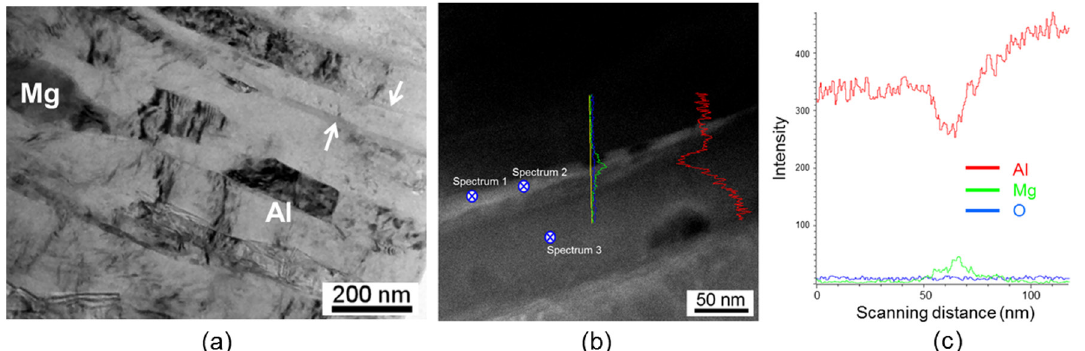
Figure 2. TEM micrographs taken at the disk edges after HPT for 5 turns showing (a) a bright-field image of a layered microstructure, (b) a dark-field image taken at the disk edge after HPT for 5 turns with the EDS scanning line marked vertically and (c) the scanning result shown in (b) as a plot of the relative intensities with respect to the scanning distance for O, Mg and Al marked in blue, green and red, respectively. 17